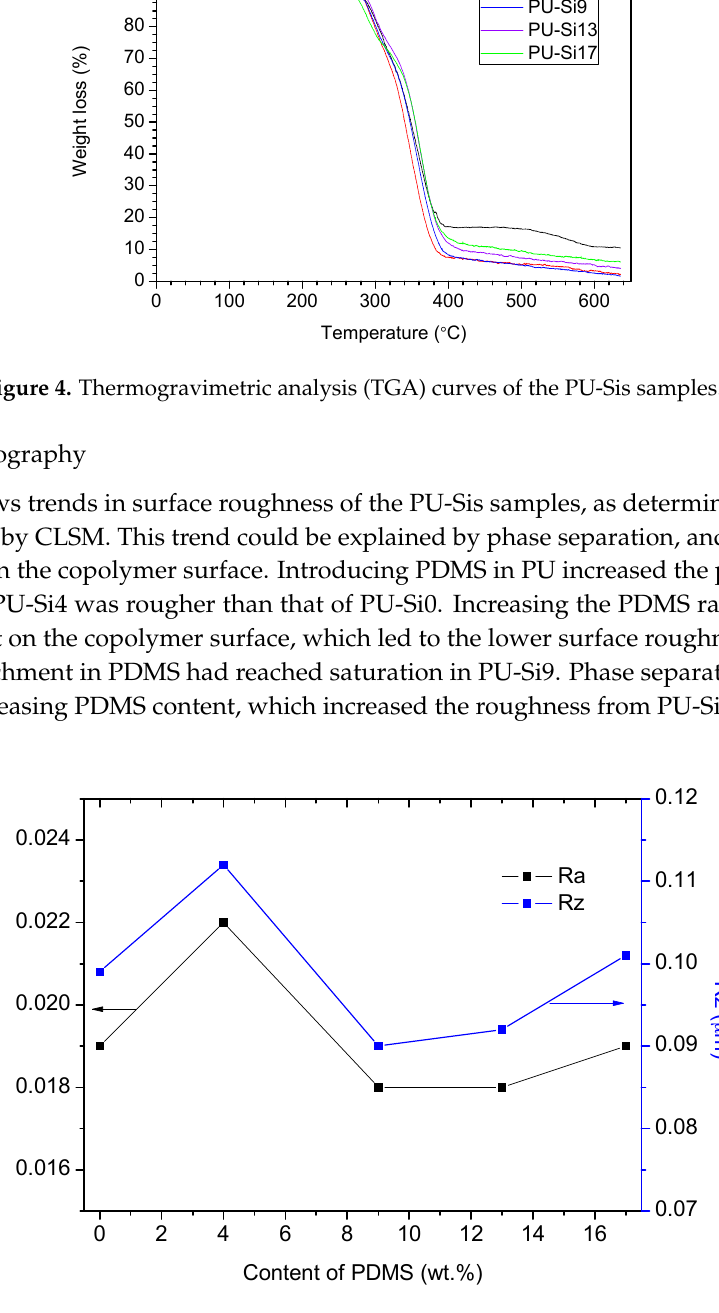
Figure 3. Differential scanning calorimetry (DSC) curves of PU-Si0 and PU-Si17.